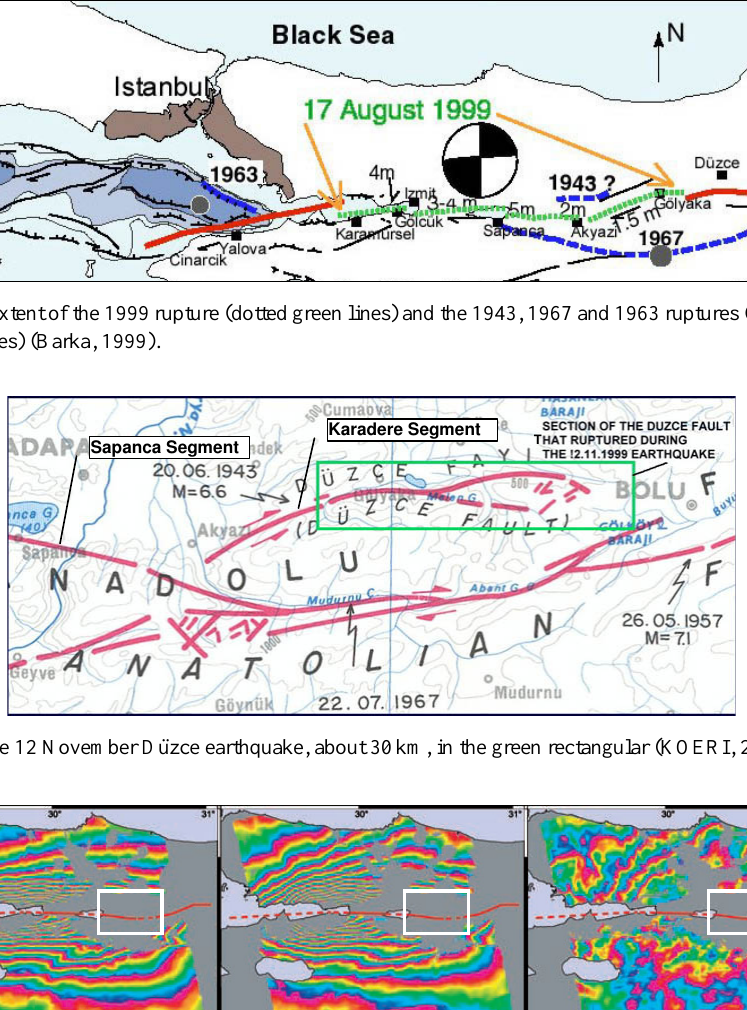
Figure 3. Interferograms of the İ zmit earthquake from ESA satellites ERS1 (12 th August–16 th 76 Fig. 3. Interferograms of the ˙ Izmit earthquake from ESA satellites ERS1 (12 August–16 September 1999) and ERS2 western İ zmit segment and the West Sapanca segment, and the maximum postseismic surface 51 September 1999) and ERS2 (13 th August–17 th September 1999). There is seen no significant 77 (13 August–17 September 1999). There is no significant interferogram obtained in the east of Sapanca Lake (from Cakir et al., 2003b). interferogram obtained in the east of Sapanca Lake (from Cakir et al., 2003b). 78 slip of 5 cm prior to the November 1999 Düzce earthquake (Reilinger et al., 2000; Cakir et 52 79 fringe corresponds a range change of 2.8 cm. As seen from al., 2003a). The maximum coseismic slip of the November Düzce earthquake was estimated 53 There was also no geodetic network in this area especially designed for tectonic monitoring 80 Fig. 3a and b, there are significant phase interferograms of deformation obtained along the ruptured fault line except at about 4 m around the mid point of the 30 km surface rupture (Cakir et al., 2003a). The 54 purposes. However there was a GPS network designed for national mapping purposes, and 81 for the area determined by the white rectangle. Since the displacement associated with the right lateral strike slip postseismic deformations after the Düzce event were studied in Cakir et al. (2003a) and 55 occurs in the East-West direction, the fringes in the figures are nearly symmetric and parallel to the fault line. The area Ergintav et al. (2009). 56 surrounded with white rectangle corresponds to the Sakarya basin that is the area of interest of this study. For the area, steep slip gradient, rough topography and water content in the soils are counted as possible reasons of obtaining no interferogram (Cakir et al.,